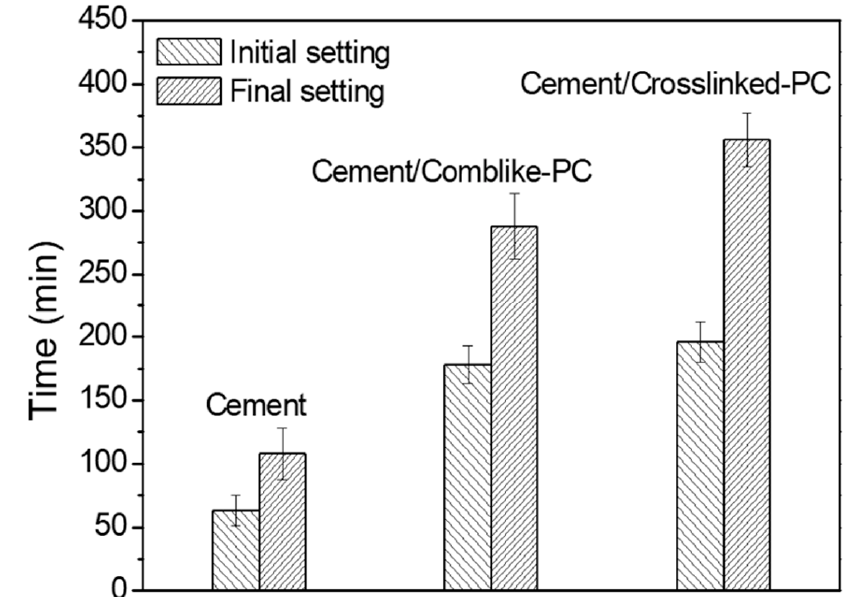
Figure 7. Setting times of cement pastes in the absence or presence of PCs (0.5% bwoc).